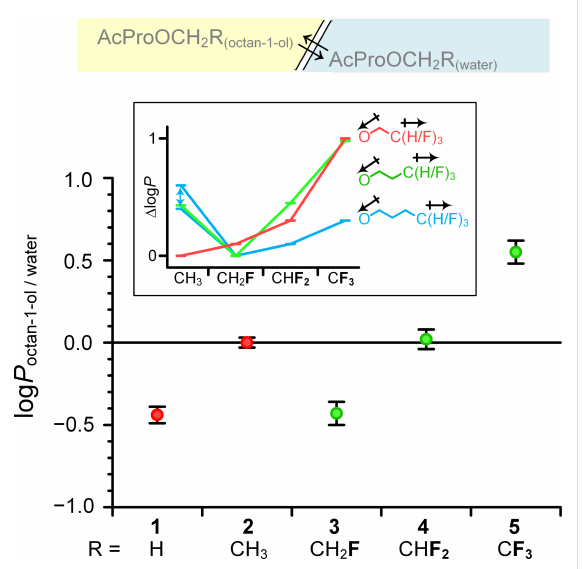
Figure 3: Partitioning of the esters 1 – 5 between octan-1-ol and water. Insert: comparison with the other partially fluorinated propoxy and me- thoxy groups from references